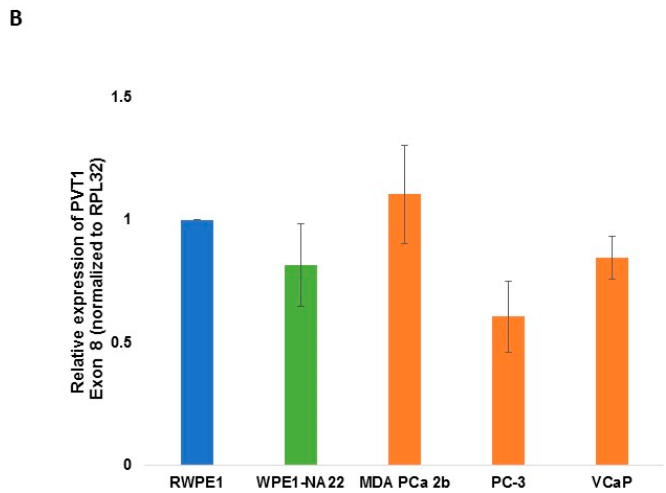
Figure 5 . PVT1 exons 7 ( A ) and 8 ( B ) expression in non-tumorigenic and tumorigenic Figure 5. PVT1 exons 7 ( A ) and 8 ( B ) expression in non-tumorigenic and tumorigenic prostate prostate epithelial cell lines. Four independent qPCR experiments were performed and epithelial cell lines. Four independent qPCR experiments were performed and every experiment was every experiment was set up in quadruplicates. The data showed that there is no significant set up in quadruplicates. The data showed that there is no significant differential expression of the differential expression of the exons in the cell lines in comparing cell lines derived from exons in the cell lines in comparing cell lines derived from CM with those derived from MoAA. The CM with those derived from MoAA. The data are presented as mean + standard error of data are presented as mean + standard error of the mean (SEM). the mean (SEM). PVT1 exon 9 was the only one of all 12 exons of PVT1 that showed a very consistent and easily explainable expression profile. PVT1 exon 9 was significantly and consistently overexpressed in both